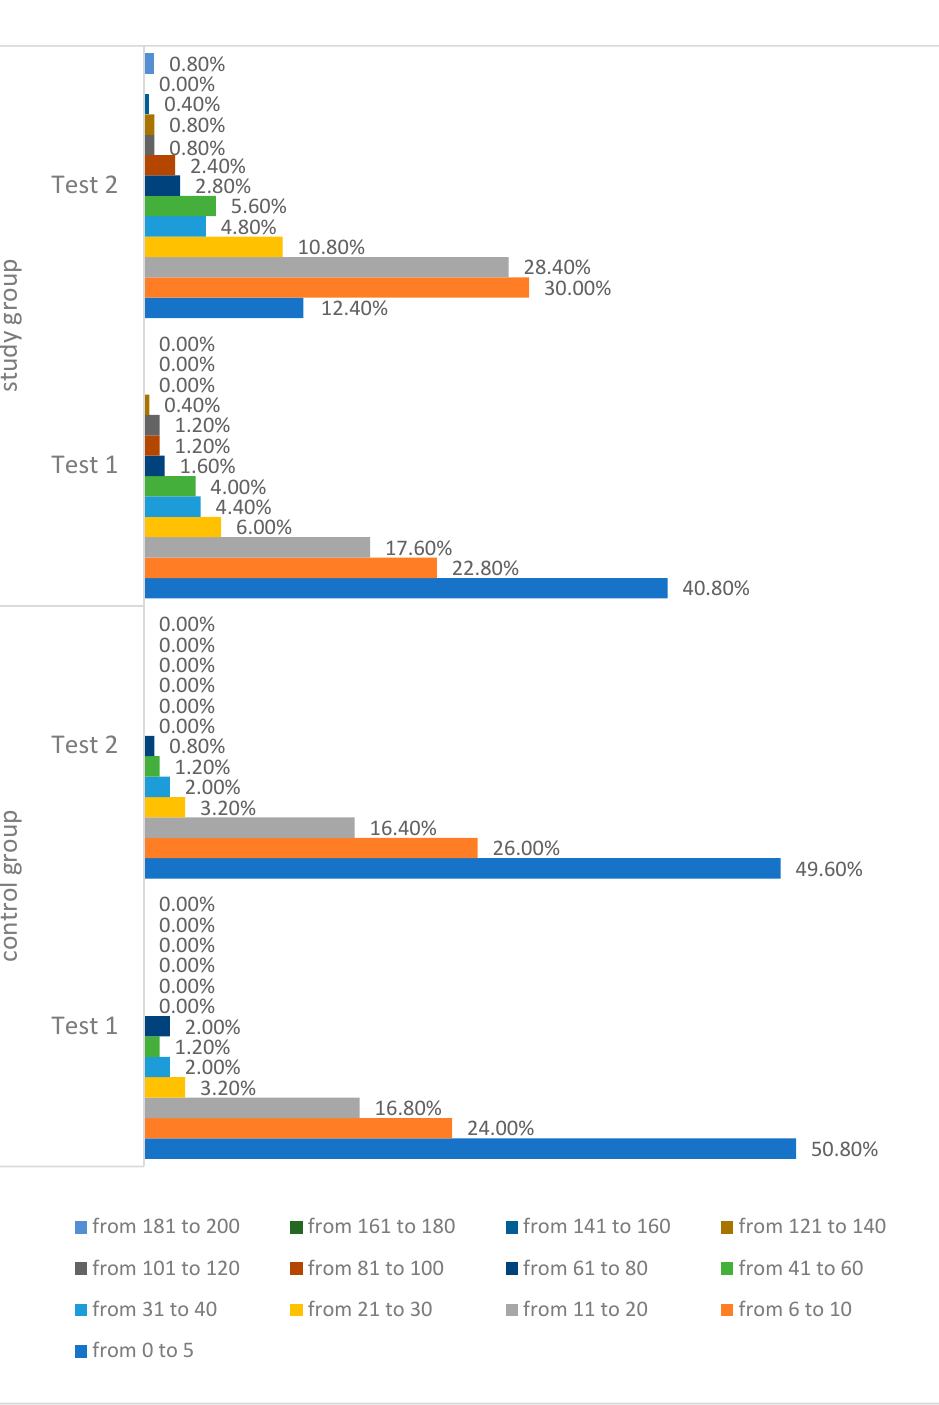
Figure 10. Proprietary interactive tactile test “breast self-examination”, number of points marked in the tactile test by individual users, Tests I and II.